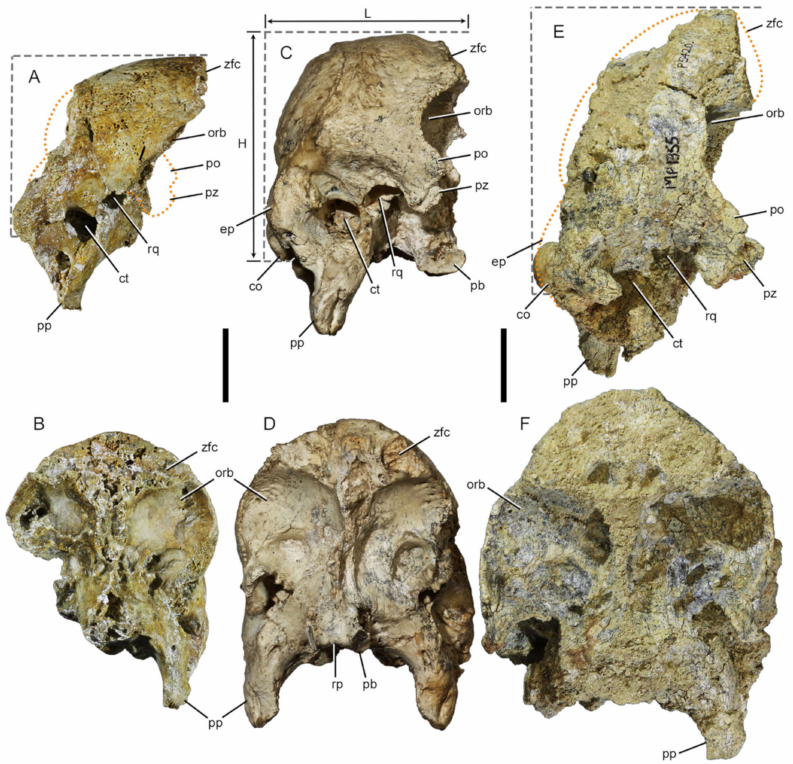
Figure 1. Time series of Dromornis specimens showing a progressive increase in cranial height (H) relative to length (L) over ~20–8 Ma: ( A , B ), Dromornis murrayi (QM F57984) Oligo–Miocene (~25–23 Ma); ( C , D ), D. planei (NTM P9464-106) middle Miocene (~15–12 Ma); ( E , F ), D. stirtoni (NTM P5420) late Miocene (~9–7 Ma). Views. Right lateral view ( A , C , E ); Rostral, ( B , D , F ). D. murrayi lateral view ( A ) shows the more complete left hand side ( B ) which has been flipped for comparison. Missing cranial areas are shown by orange stippled lines on ( A ) and ( E ). Abbreviations: ct, cavum tympanicum; ep, exoccipital prominence; mm, millimetres; orb, orbit; pb, processus basipterygoidei; po, processus postorbitalis; pp, processus paroccipitalis; pz, processus zygomaticus; rp, rostrum parasphenoidalis; rq, recessus quadratica; zfc, zona flexoria craniofacialis. Scale bars equal 40